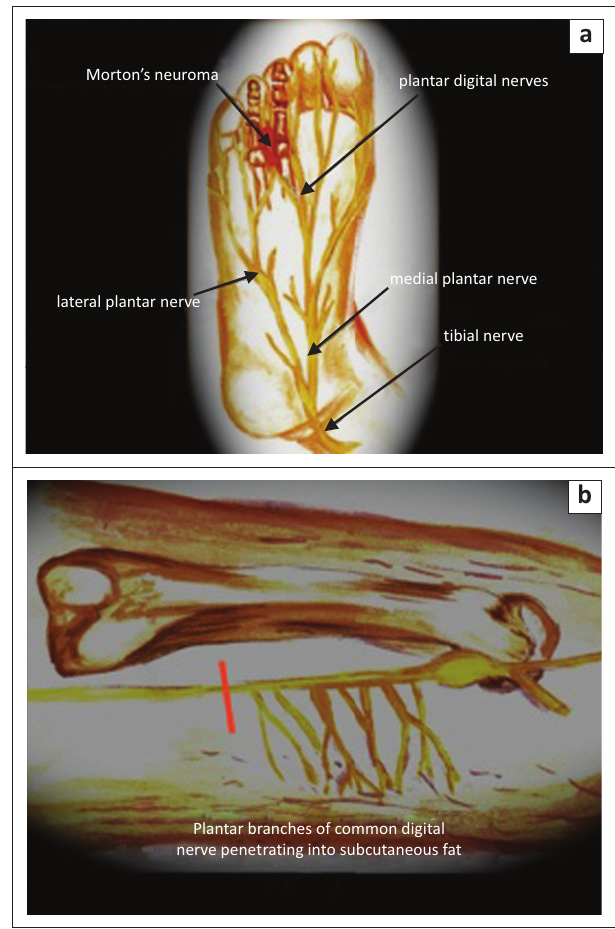
FIGURE 5: Schematic diagram illustrating the location of (a) Morton’s neuroma occurring in the webspace between the 3rd and 4th toes; and (b) the region of peripheral nerve where excision should occur to prevent the formation of a stump